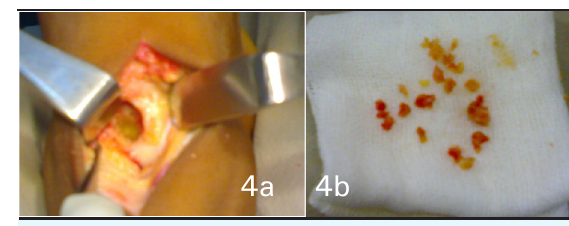
figure 4. 4a. cavity after curettage 4b. curetted